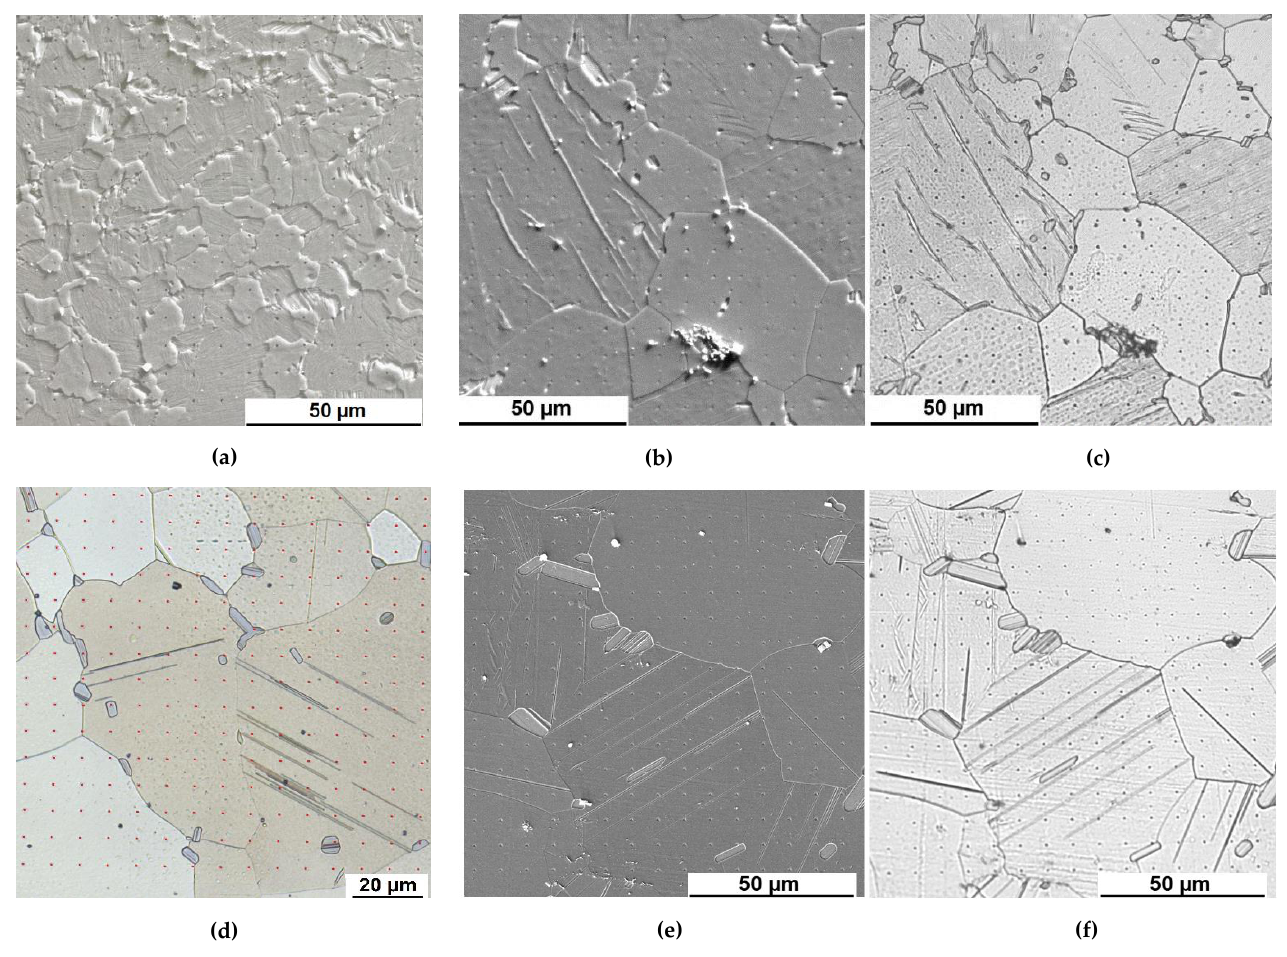
Figure 2. Micrographs of Mg-Dy-Nd-Zn-Zr alloy in extrdued state ( a ), after heat treatment at 500 °C for 0.5 h ( b , c ), 24 h ( d ) and 96 h ( e , f ) followed by quenching in 55 °C warm water, ( a , b , e ) SEM and ( c , d , f ) light microscopy, all images show the grits of 15 × 15 indents, in ( d ) marked in red.